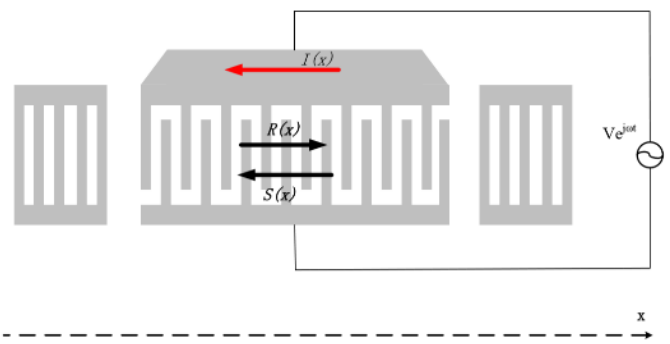
Figure 11. The COM model of the sensing device patterned by a one-port resonator.